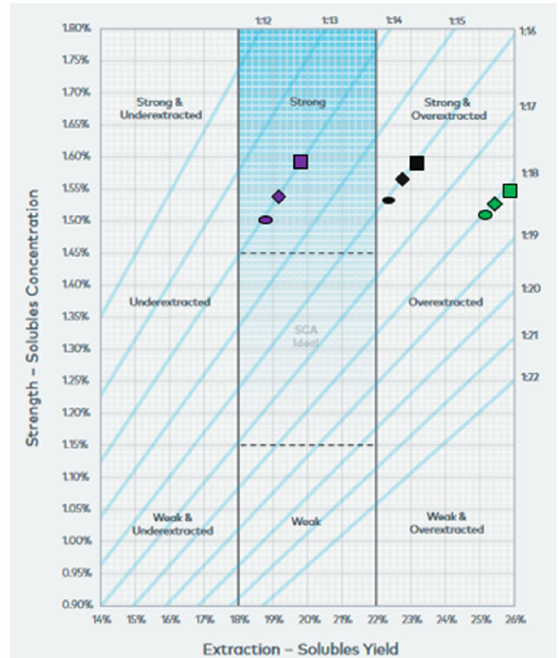
Figure 1. Coffee brewing control chart (for water hardness 70 ppm ( ■ ), 109 ppm ( ⬬ ) and 290 ppm ( ◆ ) [17].